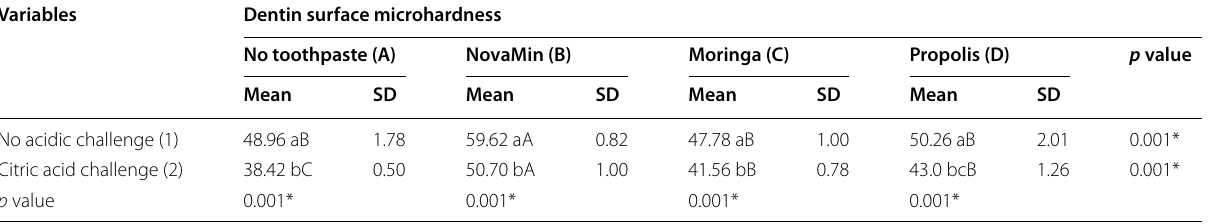
Table 2 The mean, standard deviation (SD) values of dentin surface microhardness of the tested groups Variables